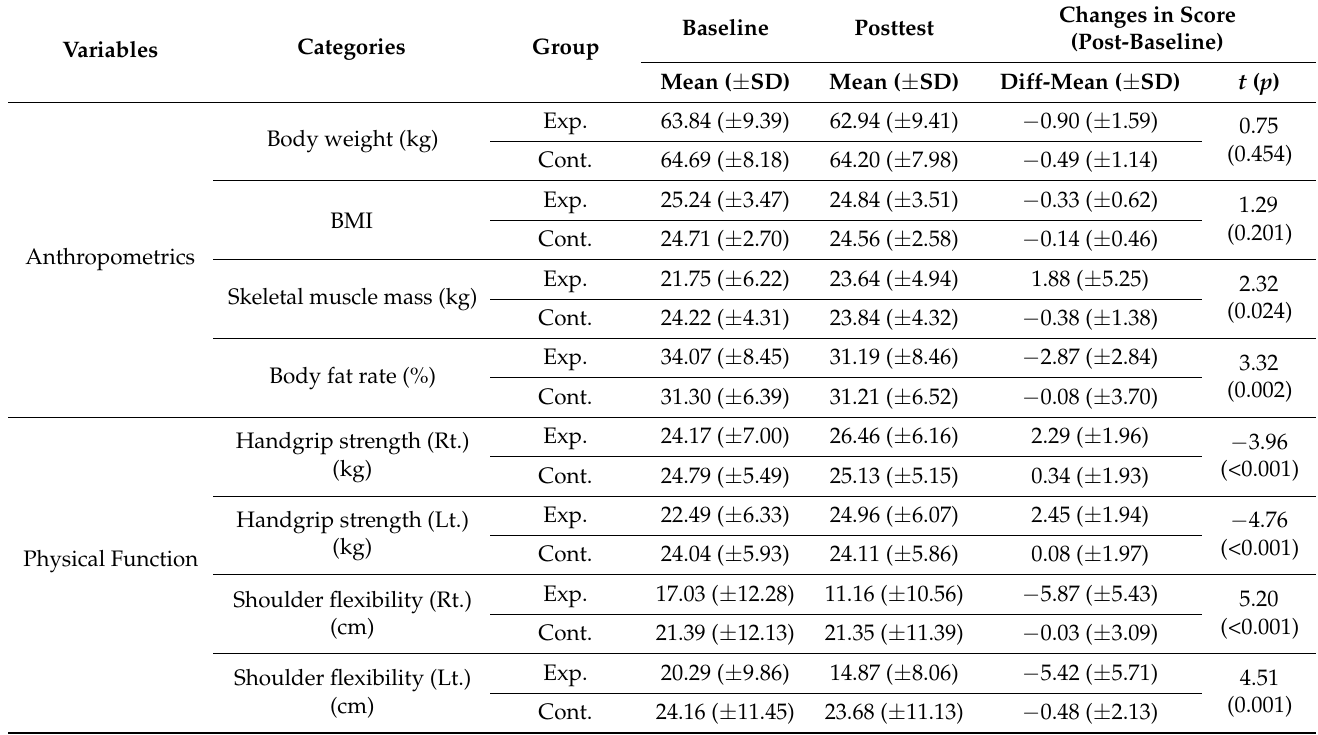
Table 4. Changes in the secondary outcomes between the groups (Exp. = 31, Cont. =